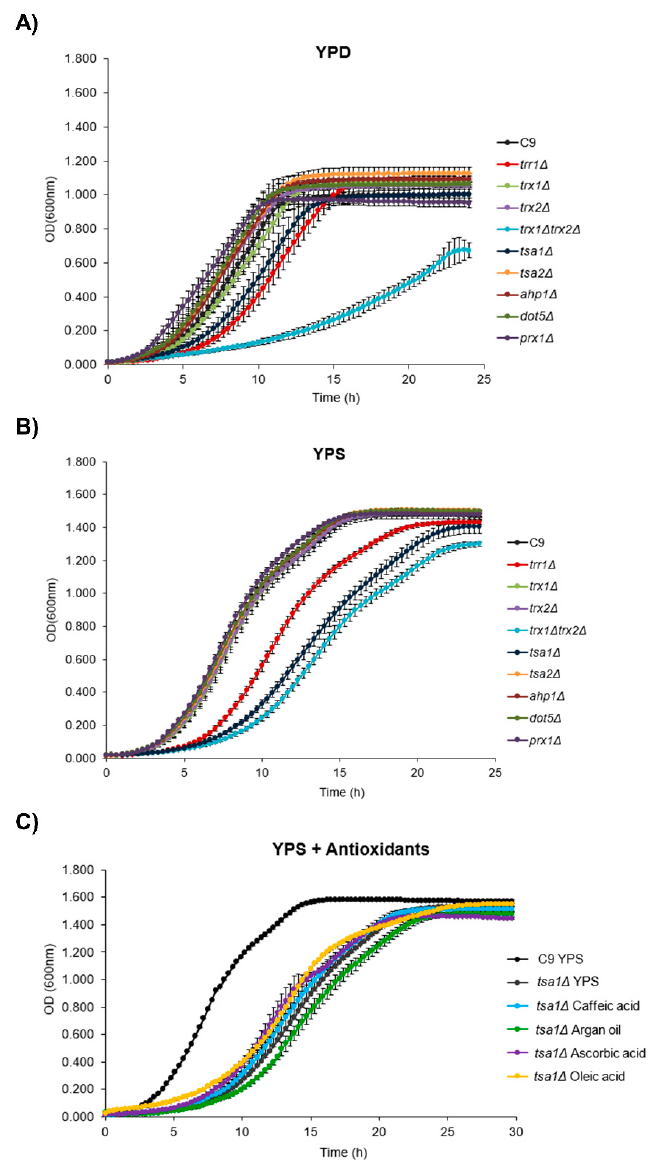
Figure 1. Peroxiredoxin TSA1 deletion impacts growth. Growth curves in multi-well plate readers of mutants in several genes of the thioredoxin system in haploid wine strain C9. ( A ) Growth in YPD medium. ( B ) Growth in YPS medium (the same as YPD, but with 6% sucrose as the carbon source). ( C ) Effect on tsa1 Δ mutant growth of adding 12 μ L/mL argan oil and pure antioxidants (5 μ M caffeic acid, 5 μ M ascorbic acid, 6 mg/mL oleic acid) to YPS. Experiments were carried out in triplicate. The